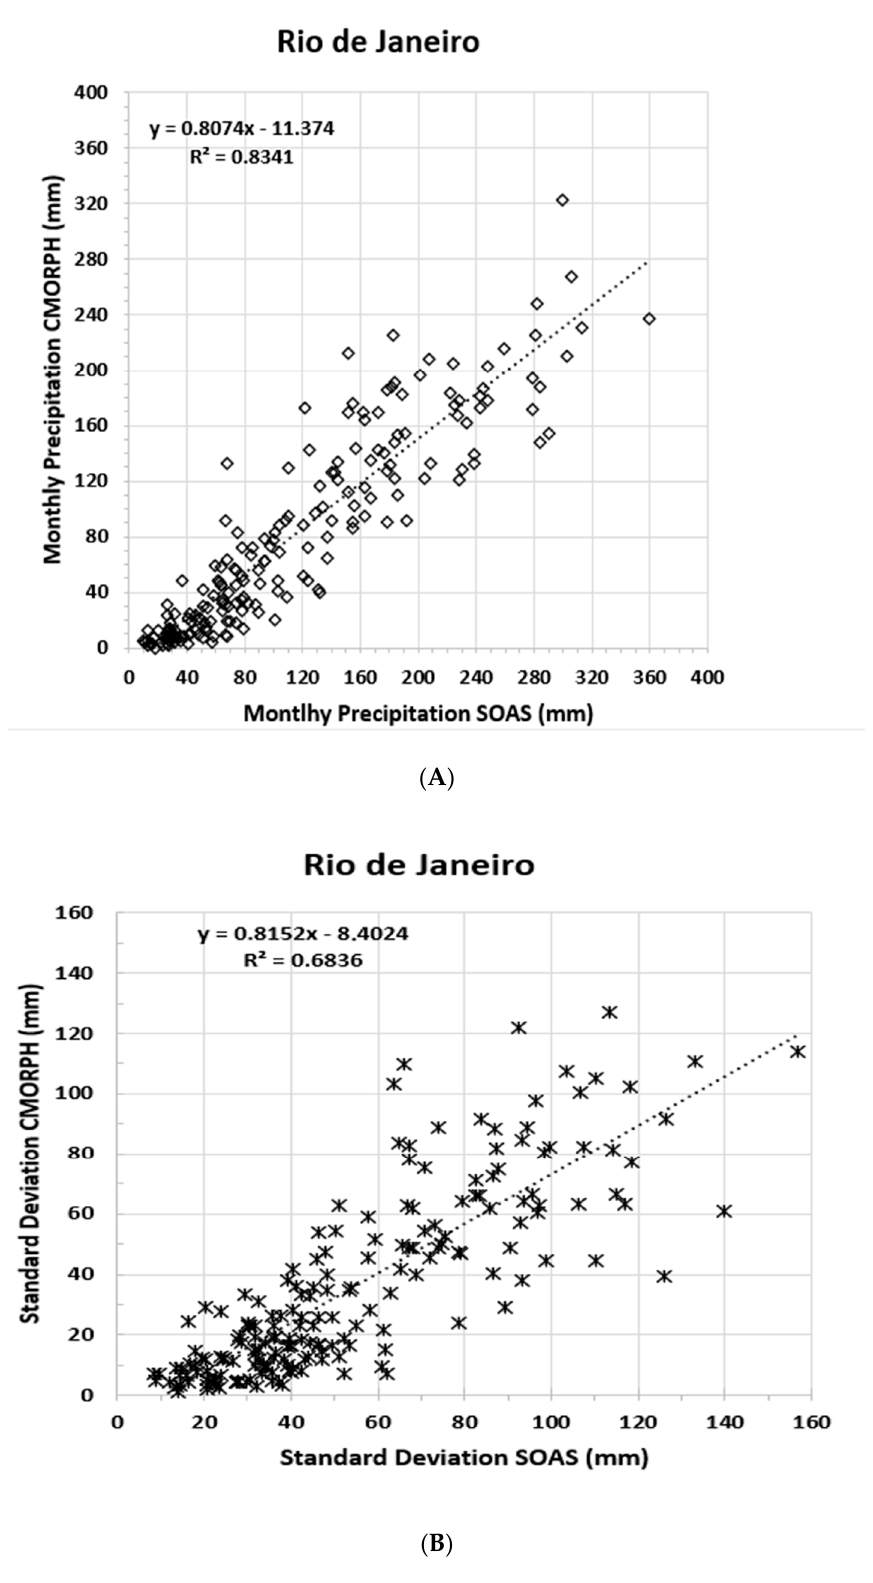
Figure 7. Scatter diagrams between mean monthly precipitation ( A ) and areal standard deviation of mean monthly precipitation ( B ) obtained with the CMORPH and SOAS method for all months of the year between 2000 and 2015 for the State of Rio de Janeiro. Linear adjustments, equations, and coe ffi cients of variation adjusted by the method of least squares are indicated.